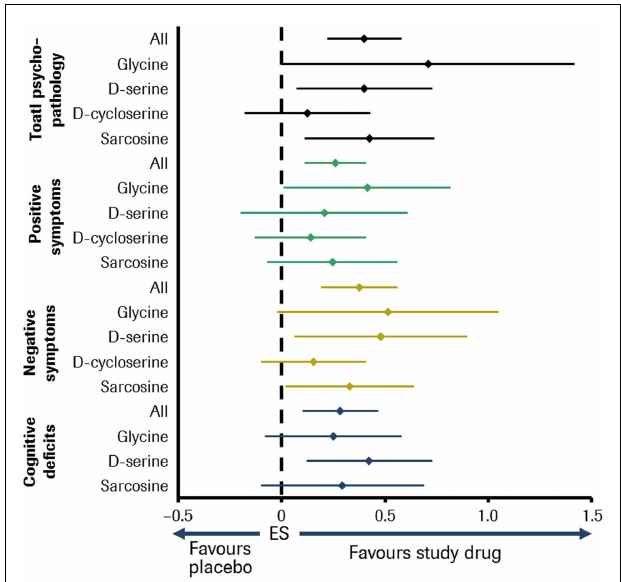
FIGURE 2 | Meta-analysis of double-blind, placebo-controlled studies of small-molecule NMDA receptor enhancers in patients with schizophrenia . Sample size: 26 studies comprising about 800 patients. Effect size (ES) for glycine, d-serine, d-cycloserine, sarcosine, and all in different symptom domains of schizophrenia [adapted fromTsai and Lin